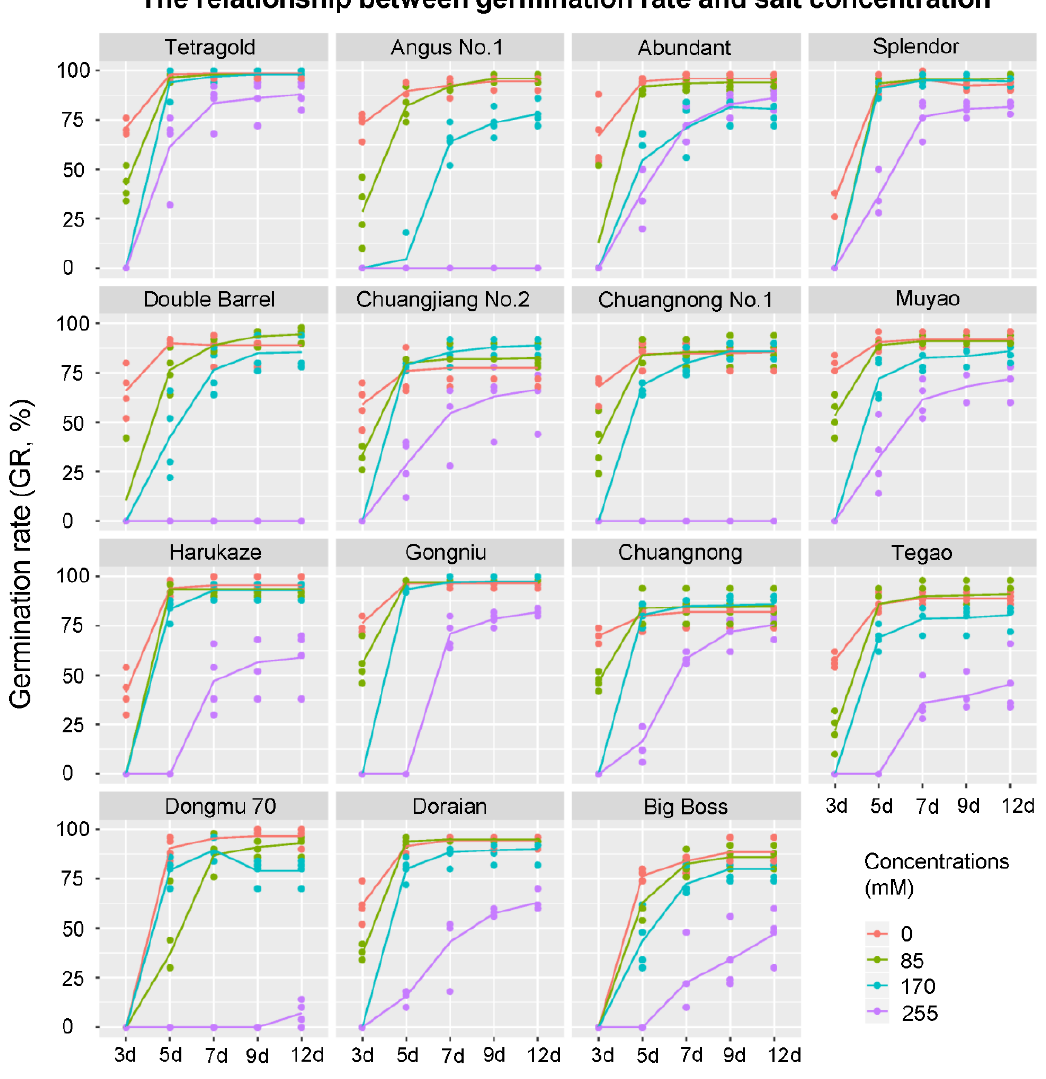
Figure 1. The germination rate (%) on the 3rd, 5th, 7th, 9th, and 12th day responses to different NaCl concentrations in 15 Italian ryegrass cultivars.